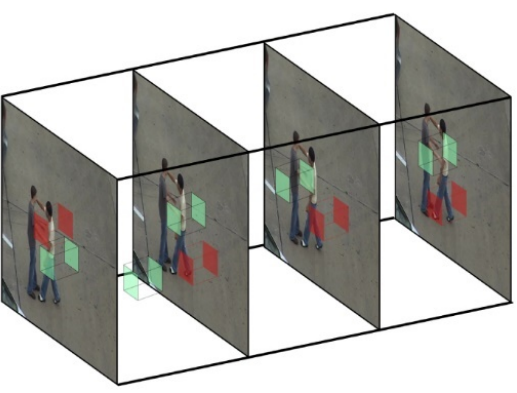
Figure 3. The view of cuboids extracted around each spatial temporal interest point for each action.